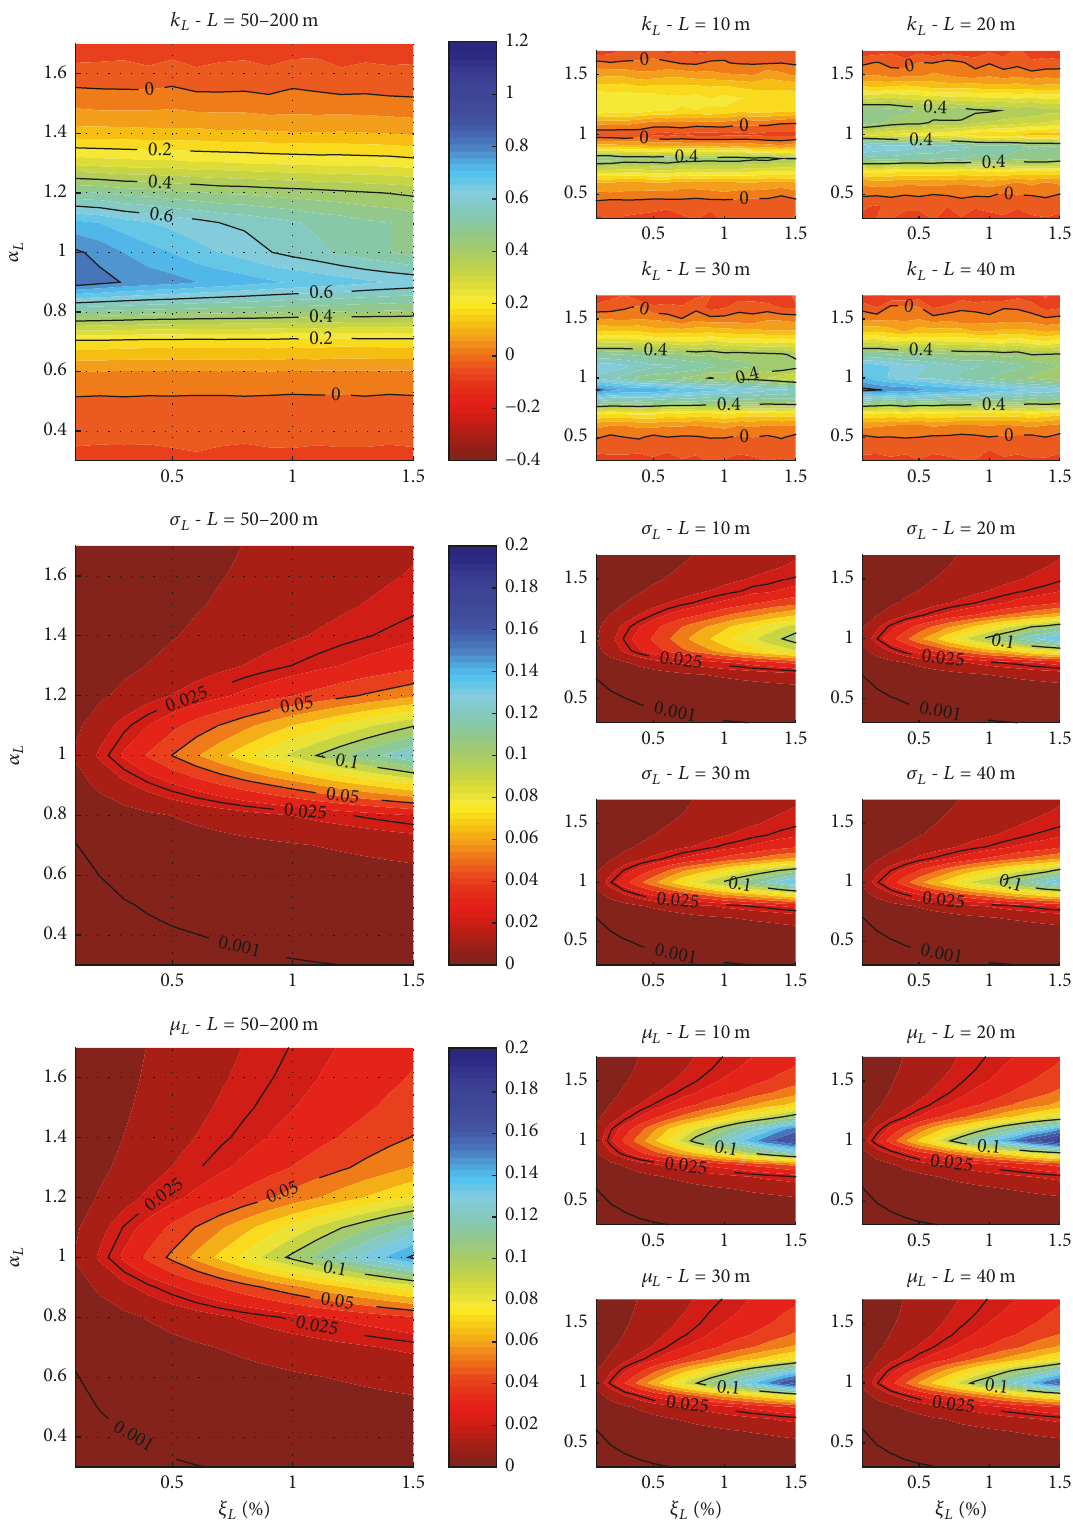
(𝜑 ( RL = 0,𝛼 ,𝐿,𝜉 )) : simply supported case in lateral 𝐿 𝐿 𝐿 𝐿 𝐿